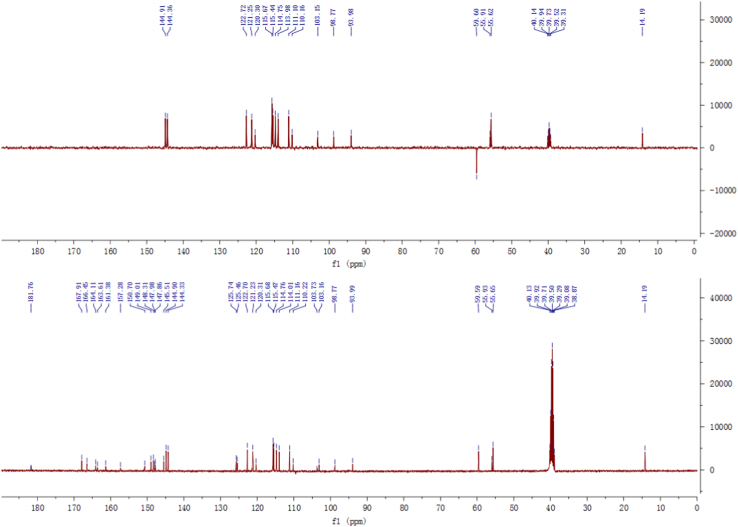
13C-NMR and DEPT spectrum of compound 3.